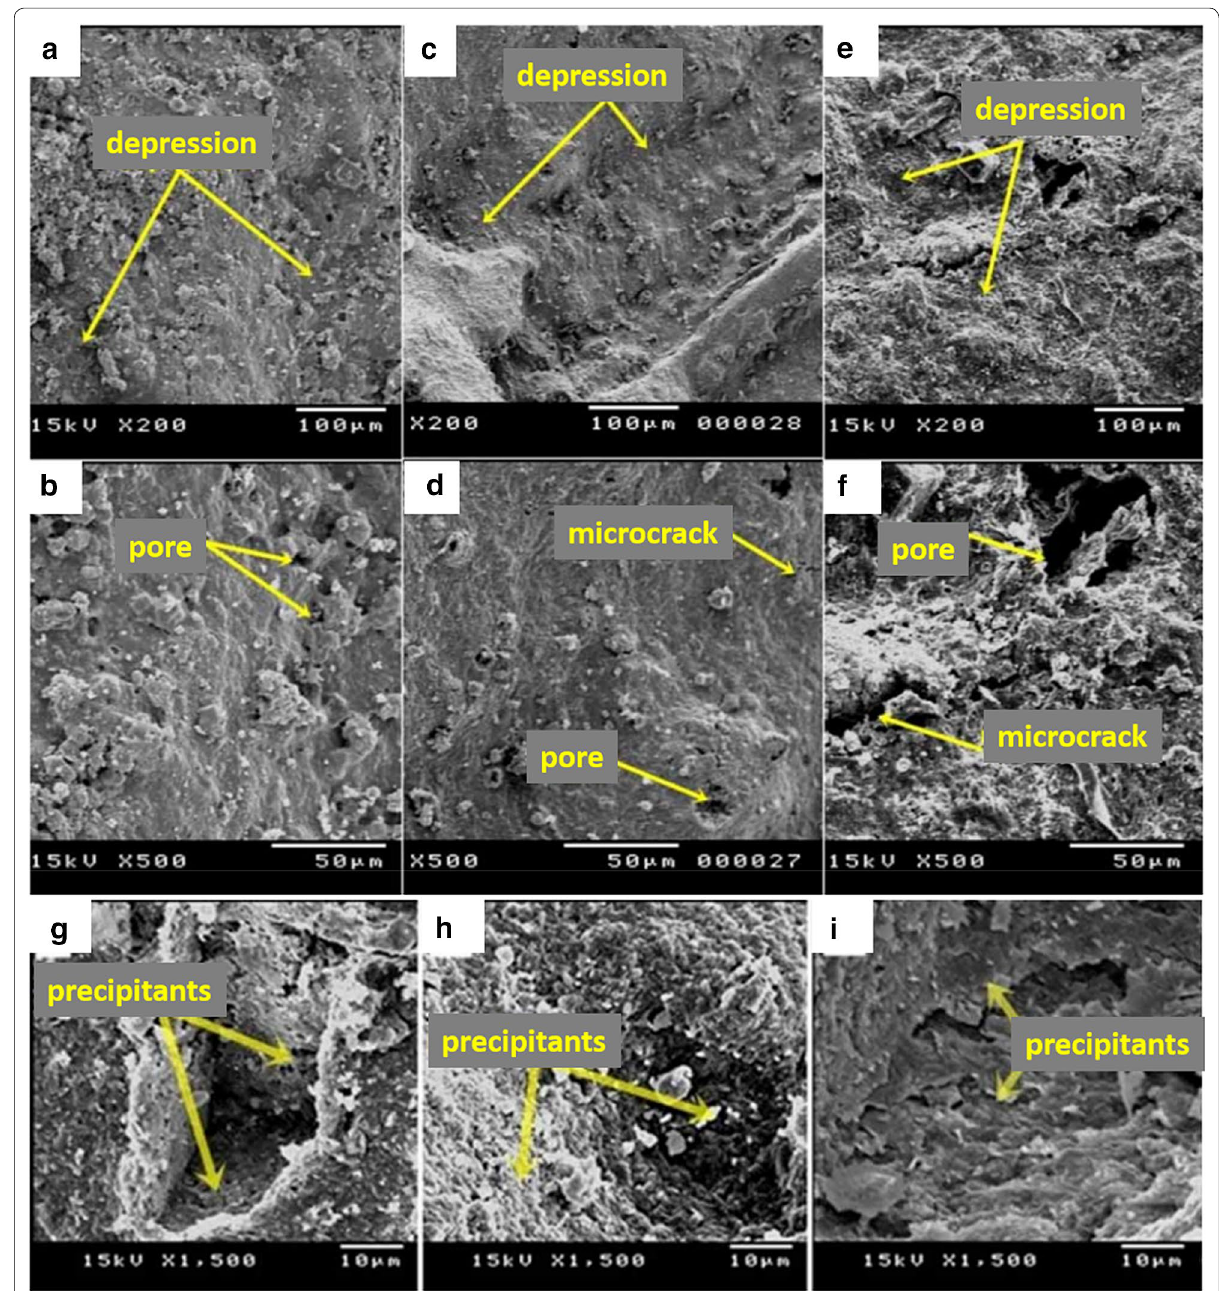
Fig. 6 SEM images magnified to 200 and 500 from top-surface of PCMs before filtration; a , b 0.5% sawdust, c , d 2.0% sawdust, and e , f 5.0% × × sawdust, respectively. SEM images magnified to 1500 from pores of PCMs after filtration; g 0.5% sawdust, h 2.0% sawdust, and i 5.0% sawdust. × (Reprinted from